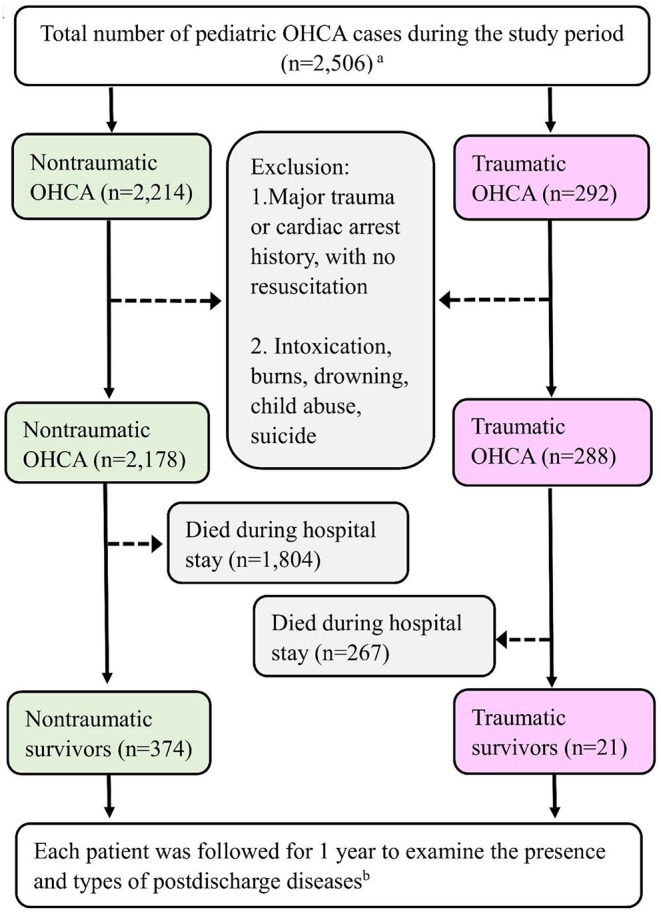
The selection principle and primary outcomes of the traumatic and non-traumatic OHCA survivors. Detailed information on the exclusion criteria is provided in the Methods section. aThe pediatric population is defined as patients aged younger than 20 years. bThe postdischarge diseases are defined as diseases that are newly diagnosed after hospital discharge.